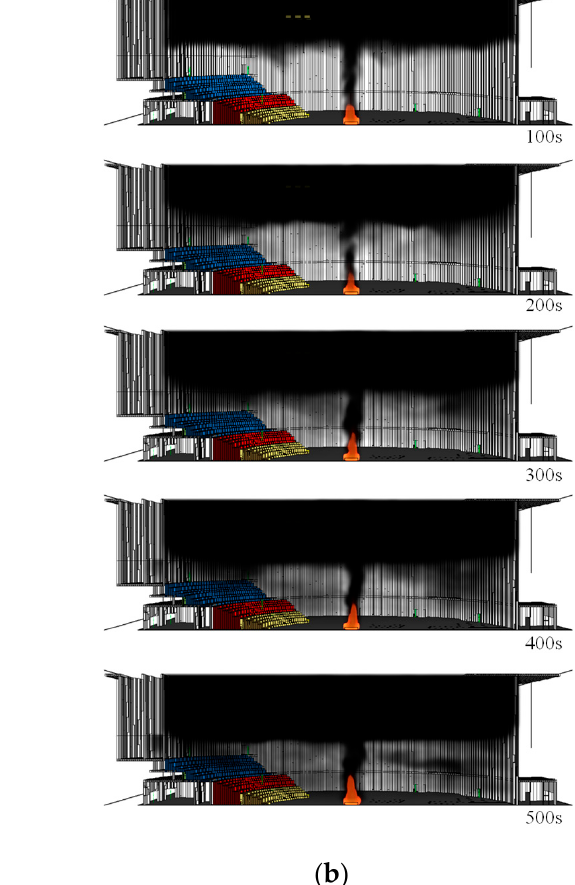
Figure 14. Smoke filling process in the theater. ( a ) Smoke extraction system off; ( b ) smoke extrac- tion system on.